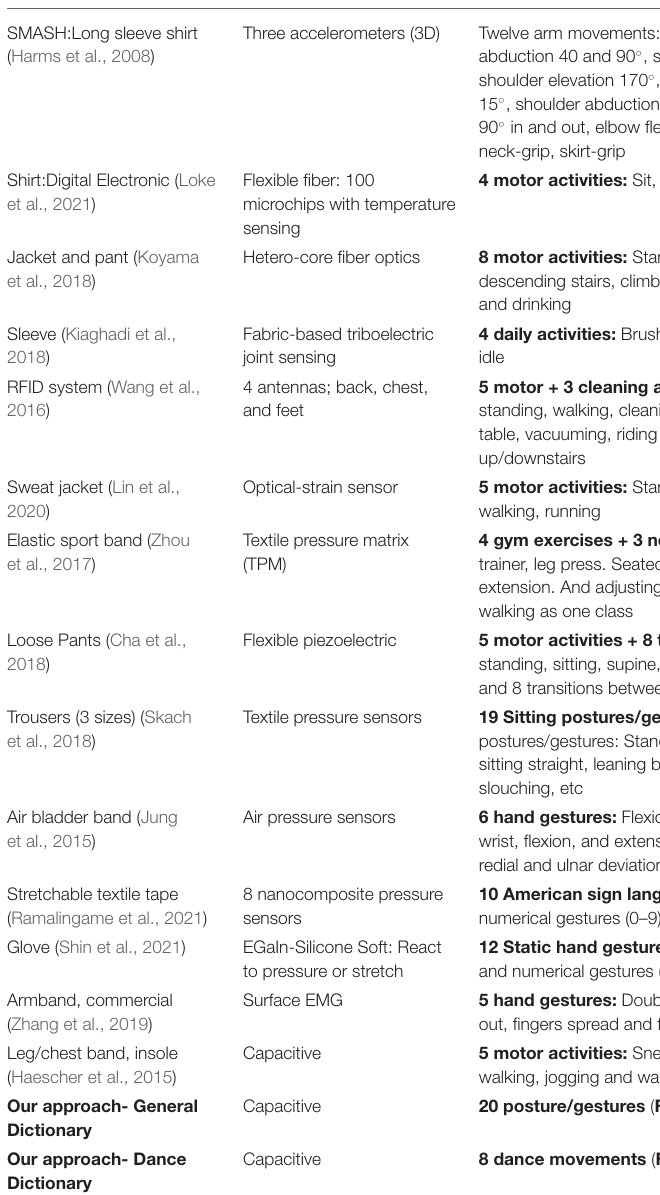
TABLE 1 | Comparison with state-of-the-art non-camera based sensing on garment methods for human activity recognition.